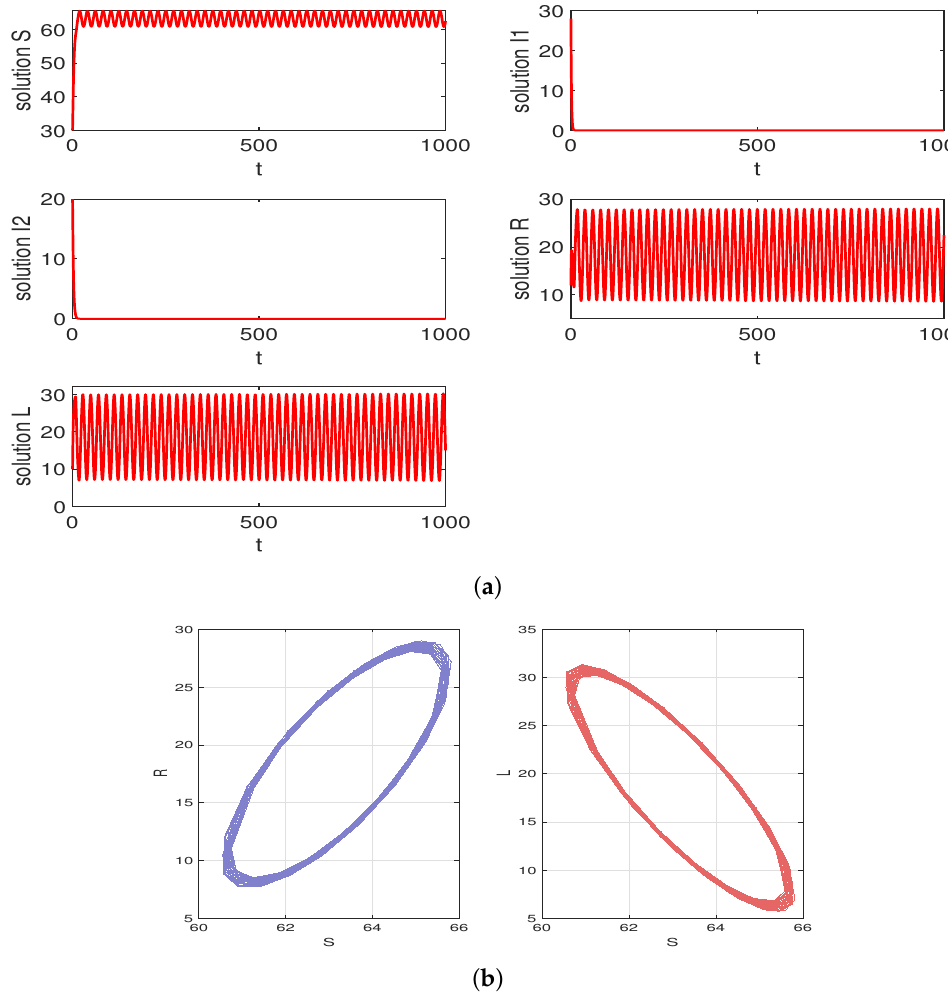
Figure 3. τ = 8.1593 > τ 10 = 8.1591. ( a ) The variation in the state nodes. ( b ) Left of Figure 3b is the relationship between S and R; right of Figure 3b is relationship between S and L